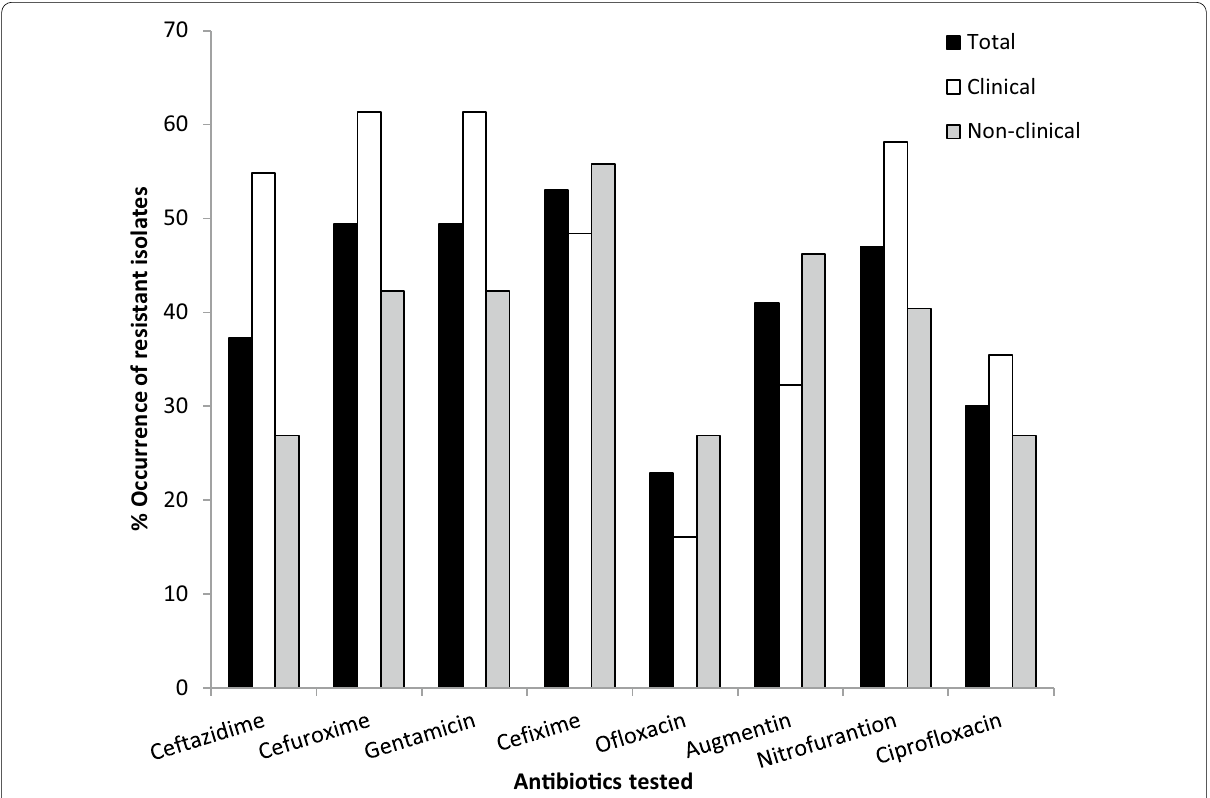
Fig. 1 Rate of bacteria resistance to tested